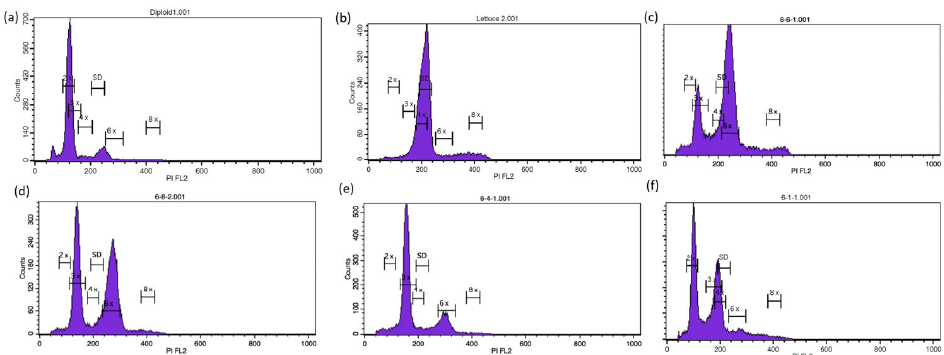
Figure 3. Examples of ploidy determination by flow cytometry in S 2 generation derived from an allohexaploid Brassica hybrid H16 ‐ 1. ( a ) Diploid control. ( b ) Lettuce control. ( c ) Large numbers of hexaploid cells and a small number of triploid cells. ( d ) Lots of triploids and a few hexaploids. ( e ) Equal numbers of triploid and hexaploid cells. ( f ) Cells containing diploids, tetraploids, and a small number of hexaploids.